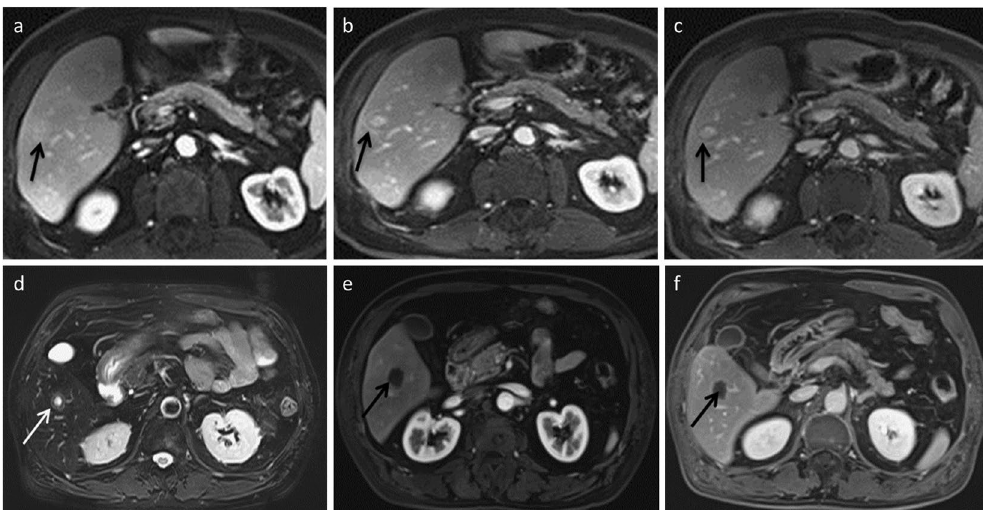
Figure 2. Two cases of hypovascular nodules. ( a – c ) Peripheral nodule cholangiocarcinoma in a 57-year- old man. ( a ) MRI of the nodule in SV, approximately 22 mm in diameter; the nodule was indistinct with an enhanced area/nodule size > 2/3 in the portal phase. ( b , c ) Delayed phase (3 and 5 min) images clearly demonstrate signs of peripheral washout, which was histopathologically proven to be a cholangiocarcinoma. ( d–f ) Solitary necrotic nodule in a 63-year-old man. On transversal fat-saturated T2WI ( d ), the center of the nodule is hyperintense relative to the liver parenchyma, but the ring-like margin of the nodule is relatively slightly hyperintense. The ( e ) arterial and ( f ) delayed phases show that the nodule has no significantly enhanced portion. The nodule was shown to be SNN by liver biopsy under ultrasound guidance and was followed up for 2 years with no changes in plain scan and DCE